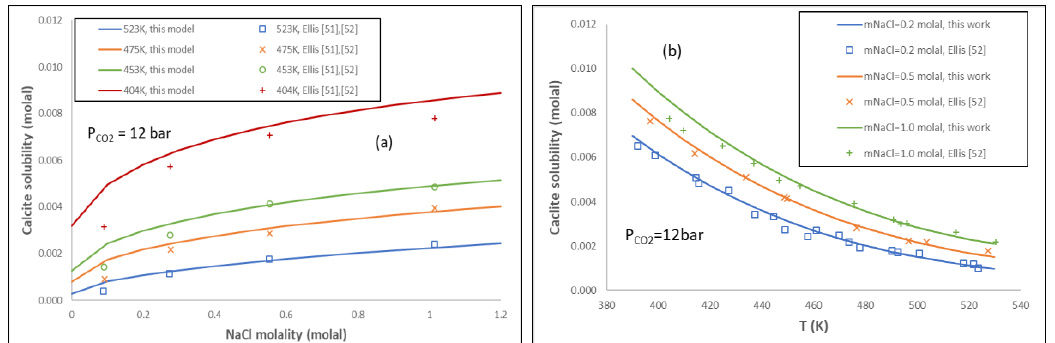
Figure 5. Calcite solubility in aqueous solution with CO 2 in equilibrium obtained from experimental data [51,52] and the calculated results using this model. ( a ) Calcite solubility varying with NaCl molality at different temperatures. ( b ) Calcite solubility varying with temperature at different NaCl molalities.